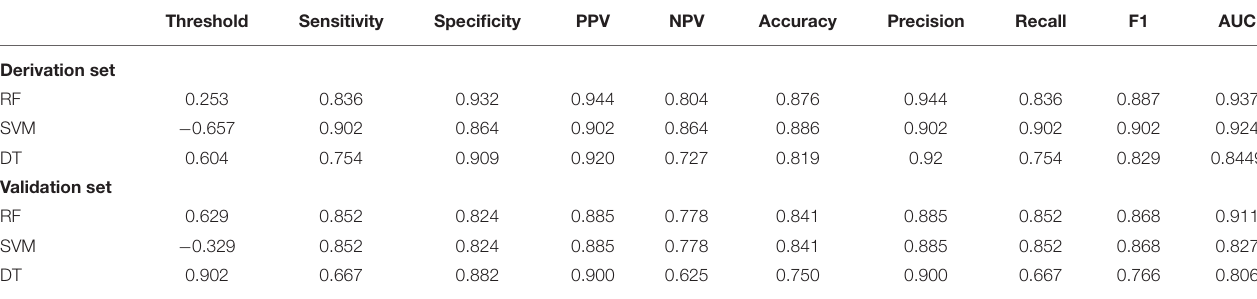
TABLE 2 | Model comparisons in differentiating PsP from TeP in derivation and validation set. Threshold Sensitivity Specificity PPV NPV Accuracy Precision Recall F1